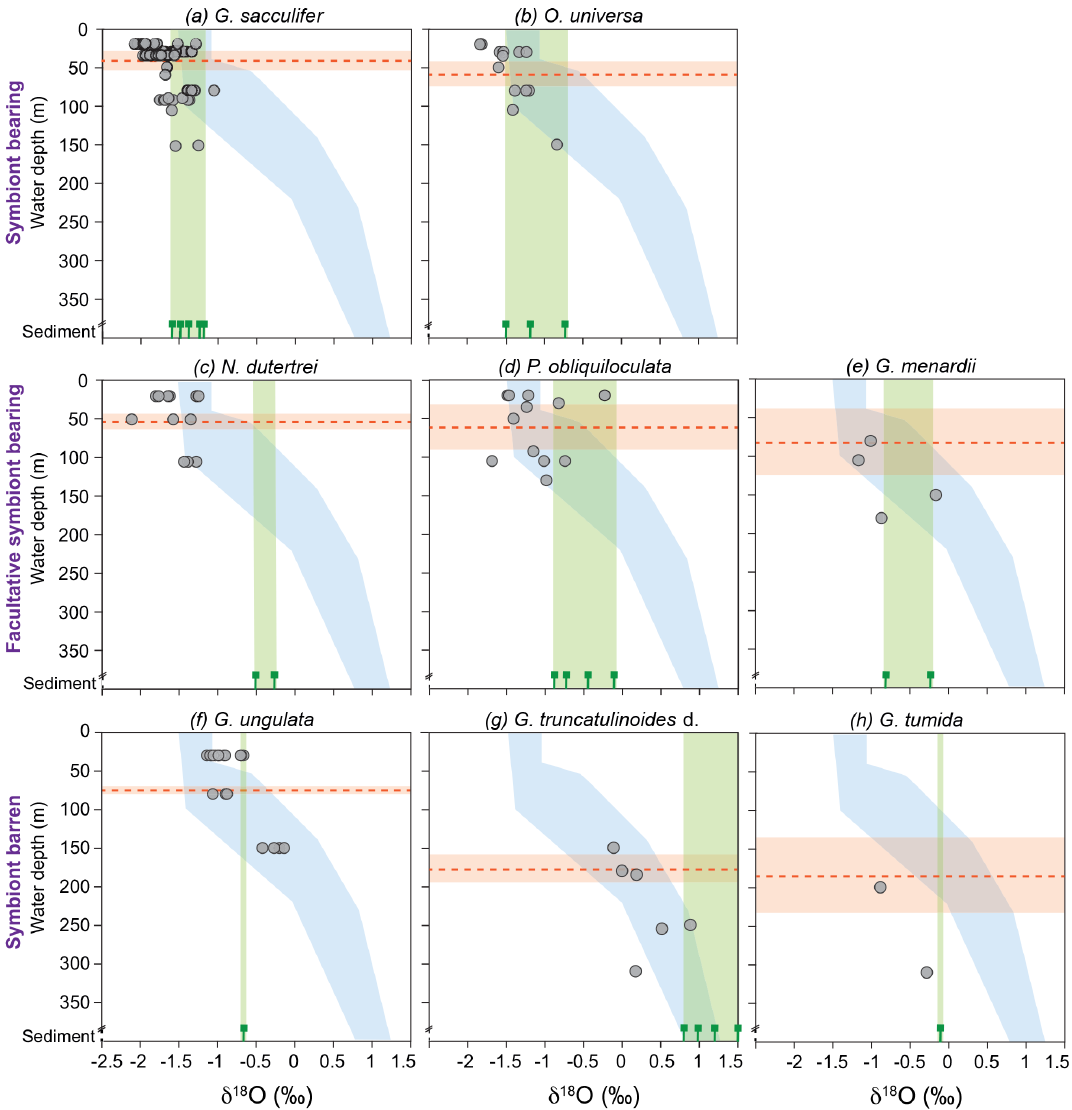
Figure 6. Stable oxygen isotopes of living planktic foraminifers from the Florida Straits and the Caribbean Sea plotted vs. water depth (m) in comparison to calculated δ 18 O equilibrium and surface sediment data (illustrating the vital effect). The foraminiferal dataset was differen- tiated into symbiont-bearing, facultative symbiont-bearing and symbiont barren species from top to bottom (Table 2; see Sect. S1 for data). Grey dots indicate foraminiferal δ 18 O calcite from MSN samples, plotted at the mean sampling depth intervals. Blue shading indicates the δ 18 O equilibrium envelope of the ambient seawater from the Florida Straits and the Caribbean Sea (see Fig. 3a). Green bars indicate the range of δ 18 O calcite of fossil tests from surface sediments (green signs are the average values of single stations; see Sect. S1). Red dashed lines indicate the average weighted living depths of single species during the sampling campaign in February–March 2009 (red shaded bars are the standard deviations; Table 2). Note that all test size fractions are